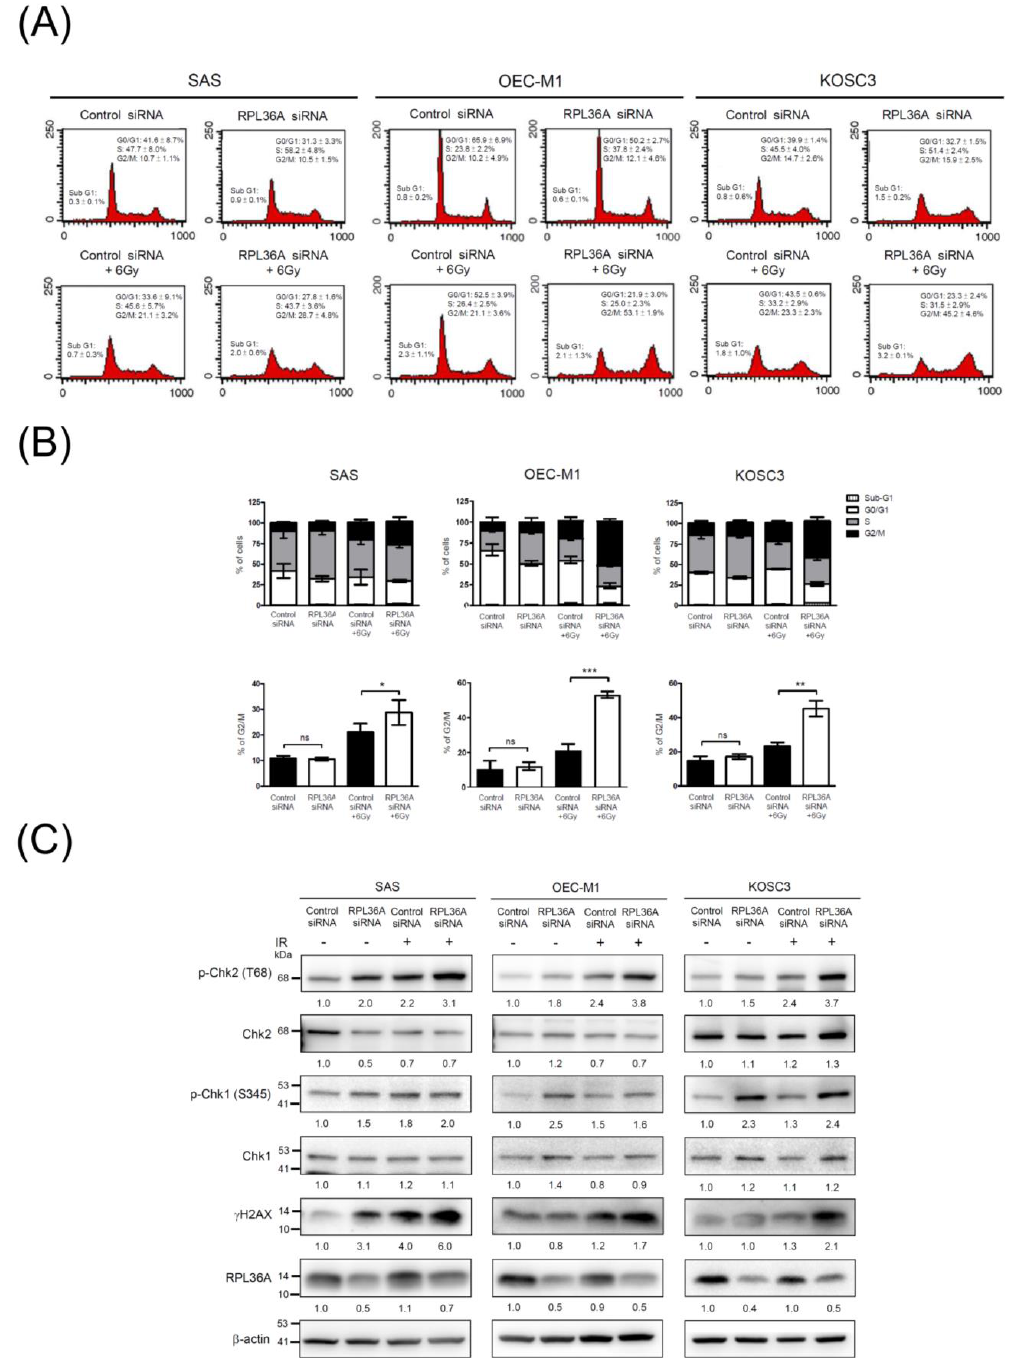
Figure 4. RPL36A depletion sensitizes cells to DNA damage and promotes G2/M cell cycle arrest in response to irradiation: ( A ) SAS, OEC-M1, and KOSC3 cells were transfected with control siRNA and RPL36A-specific siRNA. Cells were simultaneously subjected to 6 Gy irradiation, flow cytometry analysis, and Western blotting. After irradiation for 48 h, the DNA content was determined by PI staining followed by flow cytometry analysis; ( B ) the bar charts show the distribution of the transfected cells in the Sub-G1, G1, S, and G2/M cell cycle phases. Quantification analysis of the cell cycle with G2/M distributions acquired from three independent experiments. Mean values of three independent experiments ± SD are shown. The p -values were calculated by using unpaired Student’s t -test. ns, nonsignificant, * p < 0.05, ** p < 0.01, and *** p < 0.001; ( C ) total cellular proteins were subjected to Western blotting and analyzed using the indicated antibodies. β -Actin was used as an internal control. The values represent the quantified signals of Western blotting obtained from indicated antibodies and normalized to those of β